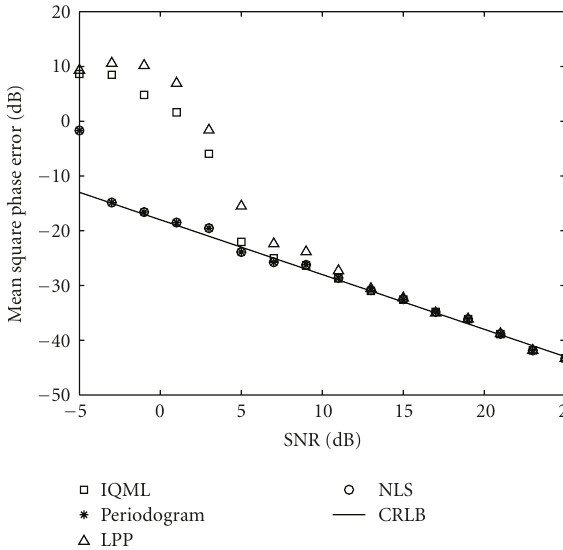
Figure 6: MSE for φ of single complex sinusoid at N =